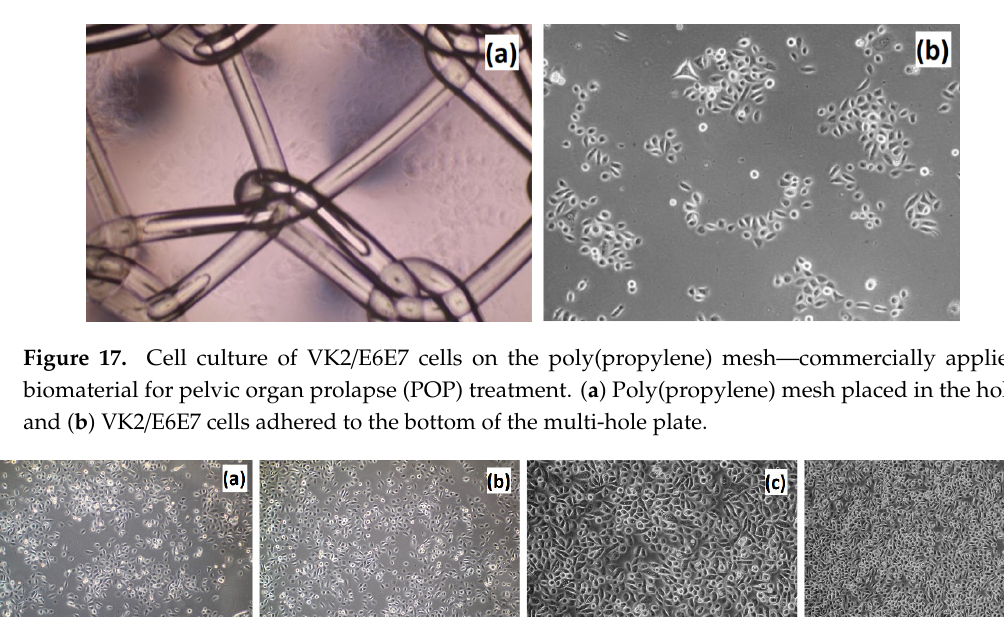
Figure 16. Cells seeded on the scaffolds and then transferred after few hours to a new hole containing fresh culture medium (sample 1—chitosan crosslinked with adipic and malonic acid; sample 2—chitosan crosslinked with adipic and L -glutamic acid; sample 3—chitosan crosslinked with adipic, L -glutamic and malonic acid; sample 4—chitosan crosslinked with adipic and levulinic).